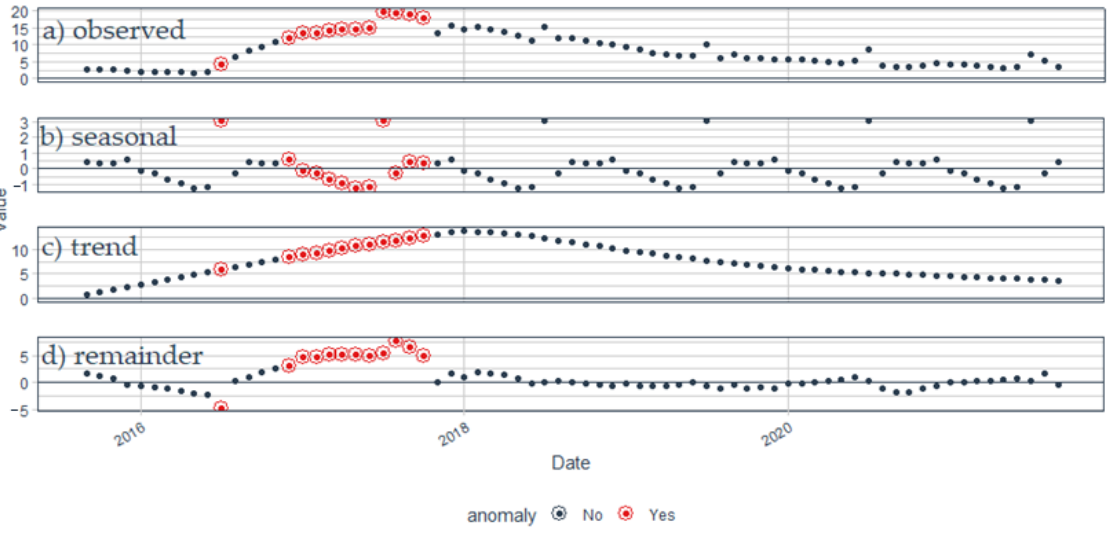
Figure 3. Removal of both seasonal and trend component to build the remainder time series 5km from Negribreens terminus (Y-axis in m/day). ( a ) shows the observed values for each time step. ( b ) the underlying seasonal component, which also shows the seasonal fluctuation in surface velocity. ( c ) is the trend curve, in this case strongly biased by the surge itself. ( d ) is the remainder upon which the GESD is applied to determine outliers (red marked dots).